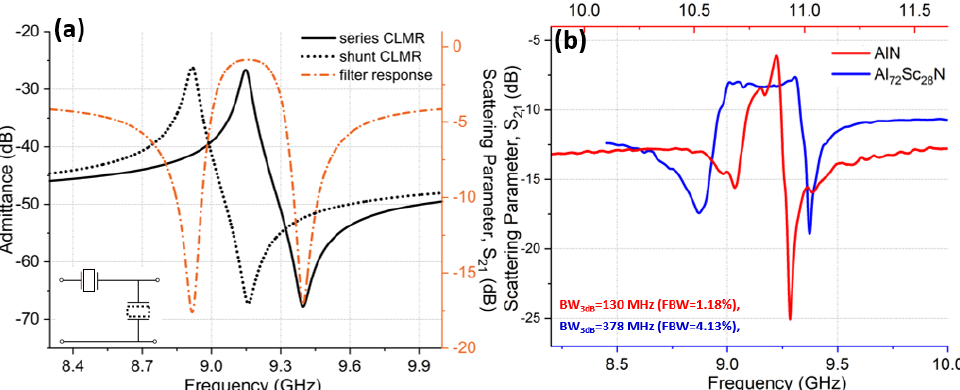
Figure 17. Simulated and measured filter response of AlN and Al 72 Sc 28 N filters: ( a ) Comsol 2D simulated admittance of Al 72 Sc 28 N series and shunt CLMRs along with the S21 scattering parameter of the 2nd order Ladder filter. ( b ) Measured S21 filter response of AlN and Al 72 Sc 28 N